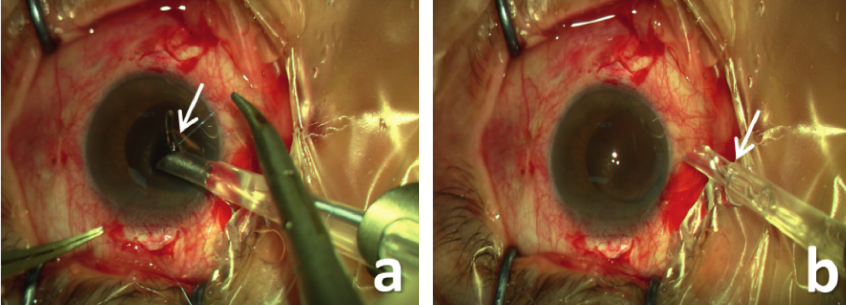
Figure 1: Sutured scleral-fixated implantation with a one-piece foldable IOL. (a) The suture was tied to the maximum radian of the IOL haptic with at least 5 knots. (b) After withdrawing the plunger, the haptic drew back into the